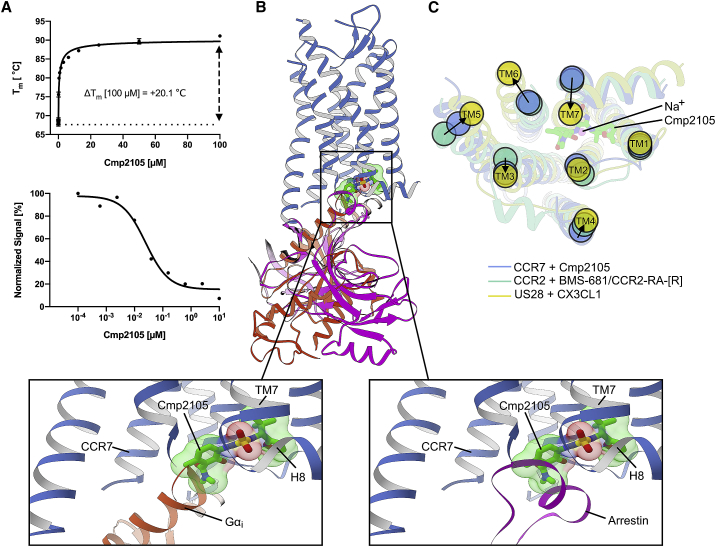
Cmp2105 Exerts Intracellular Allosteric Inhibition of CCR7(A) Thermal-shift assays (top) verify binding of Cmp2105 to CCR7. Increasing concentrations of Cmp2105 reveal a strong dose-dependent stabilizing effect on CCR7 of up to 20.1°C (mean ± SEM from 3 independent experiments with 3 measurements each). Cmp2105 allosterically inhibits binding of the native chemokine CCL19 ligand in scintillation proximity assays (bottom) with a half inhibitory concentration (IC50) of 35 nM.(B) Overlay of the CCR7 structure with the position of the Gαi subunit (Kang et al., 2018) (red) or arrestin (Kang et al., 2015) (purple) in structures of rhodopsin signaling complexes. The comparison places Cmp2105 (green; sticks and spheres) in a position where it interferes with binding of these GPCR effector proteins.(C) A structural comparison with the inactive conformation of CCR2 (Zheng et al., 2016) and the active conformation of the viral US28 with bound chemokine (Burg et al., 2015) suggests Cmp2105 to stabilize an inactive CCR7 conformation with closed intracellular effector binding site. View from the cytoplasmic side with arrows indicating relative positions in the inactive and active GPCR conformation. Our assignment to a deactivated CCR7 is further confirmed by a putative sodium ion in a conserved site between TM2, TM3, TM6, and TM7, which is known to negatively modulate activity in many GPCRs (Liu et al., 2012). Our results thus show how Cmp2105 exerts allosteric antagonism close to the intracellular G protein binding pocket of CCR7.